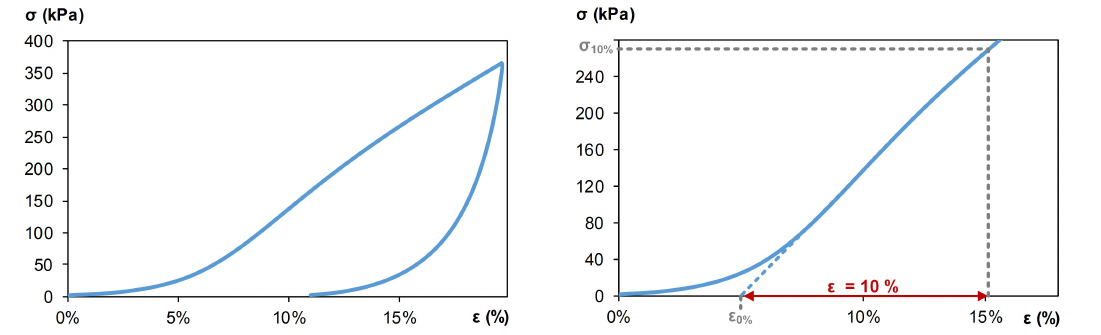
Figure 9. Stress-strain curves for composite A.i.